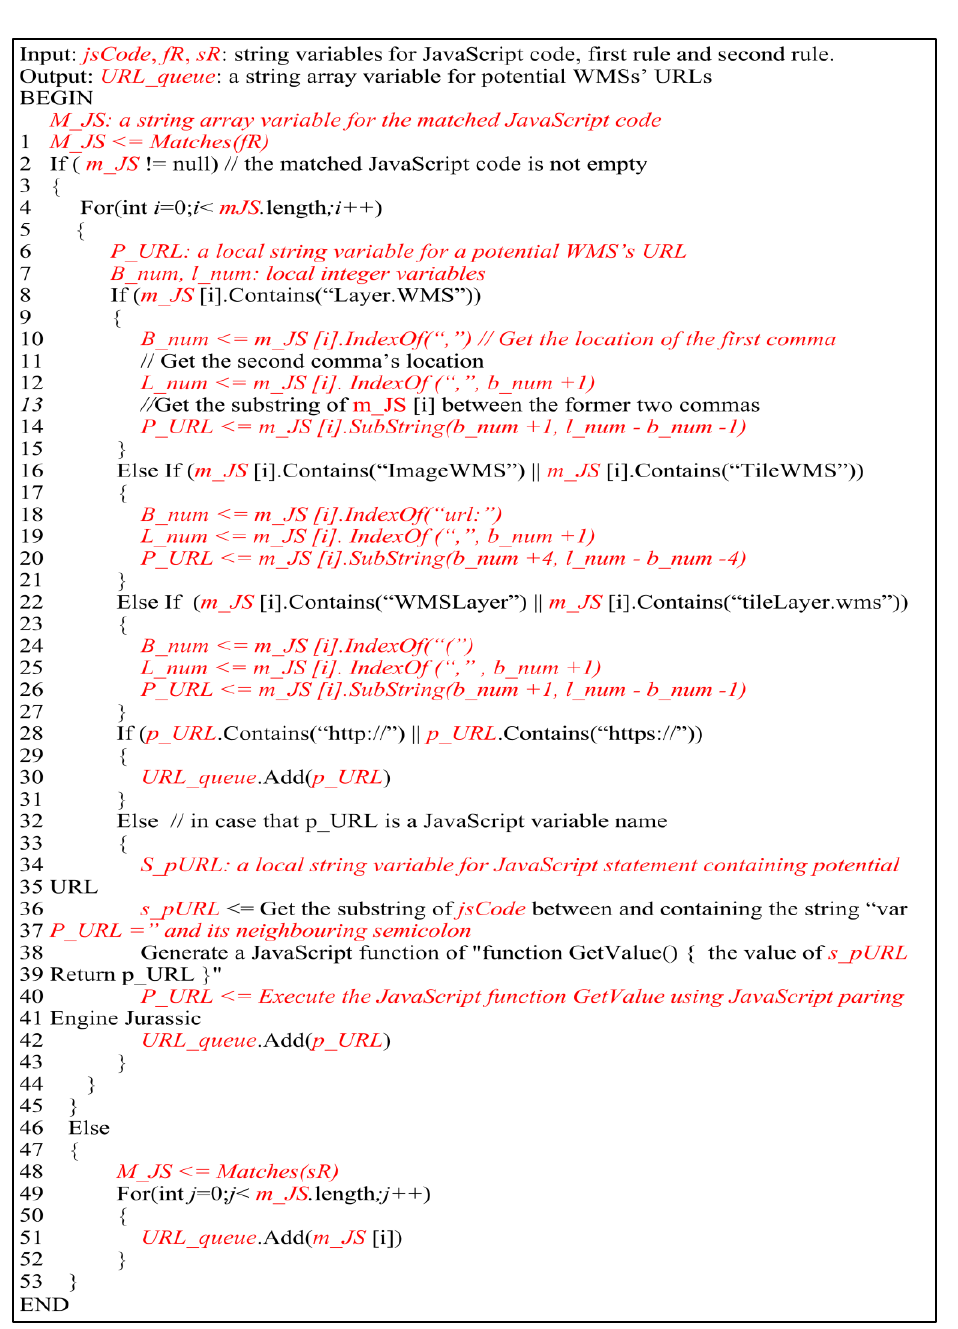
Figure 5. Pseudocode of the use of the JavaScript invocation rules.